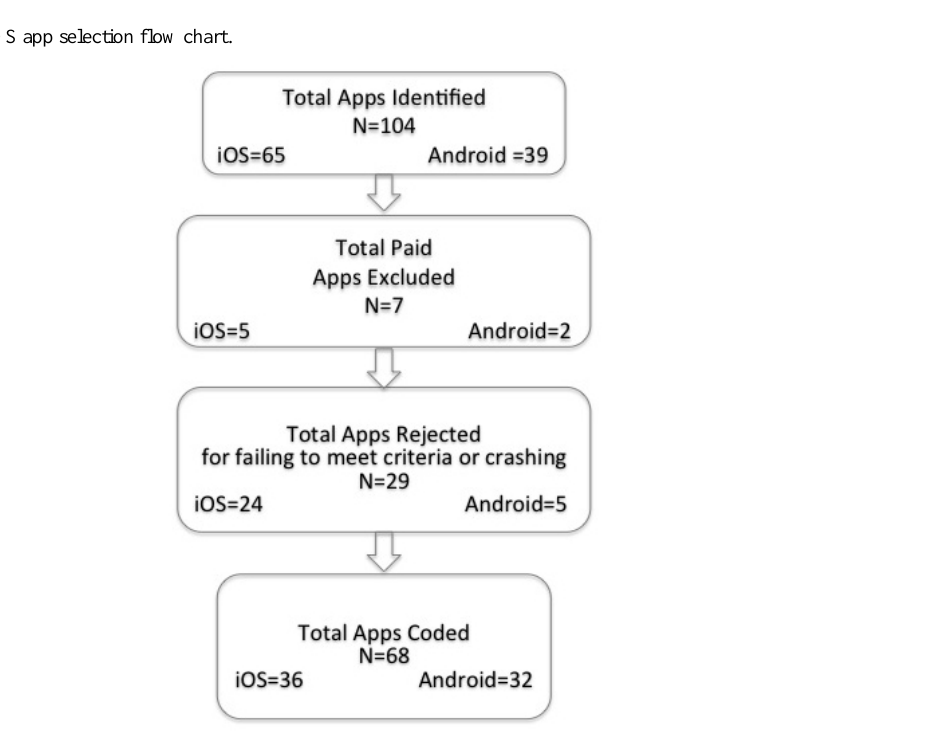
of the percentages and interpretation of the results is found in the section following Table